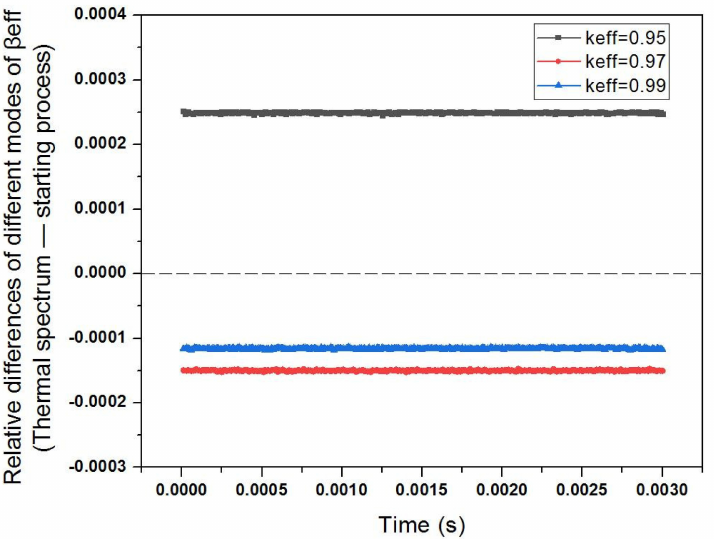
Figure 12. Relative differences in β eff with time for different modes of the thermal spectrum, under different subcriticalities and starting